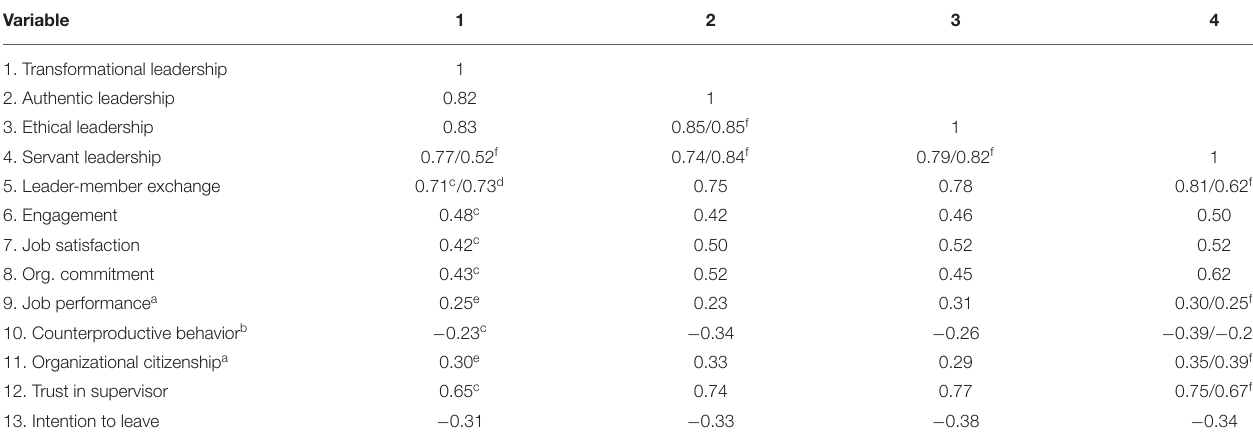
TABLE 5 | Meta-analytic correlations summary from current and prior studies. Variable